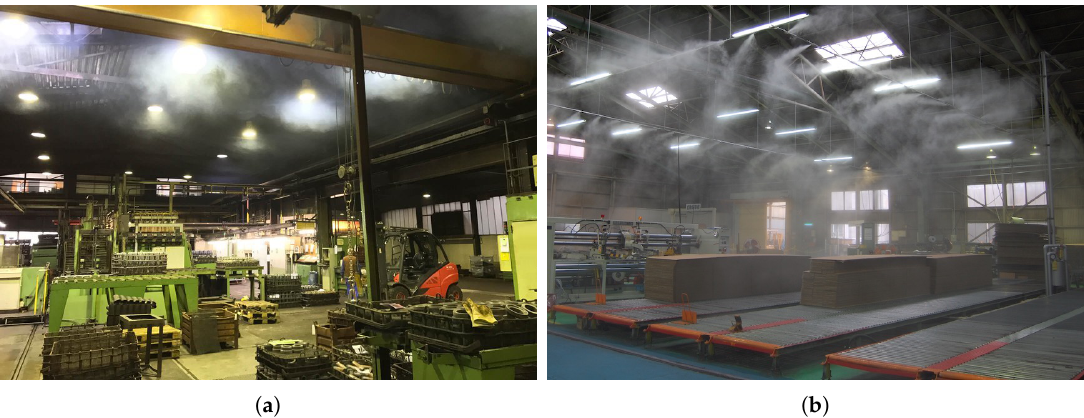
Figure 3. ( a ) A daily occurrence in a heat treatment facility with ambient temperatures of up to 60 ◦ C oil vapors [166]; and ( b ) an industrial misting system [167]. Reproduced with permissions from DIAL and